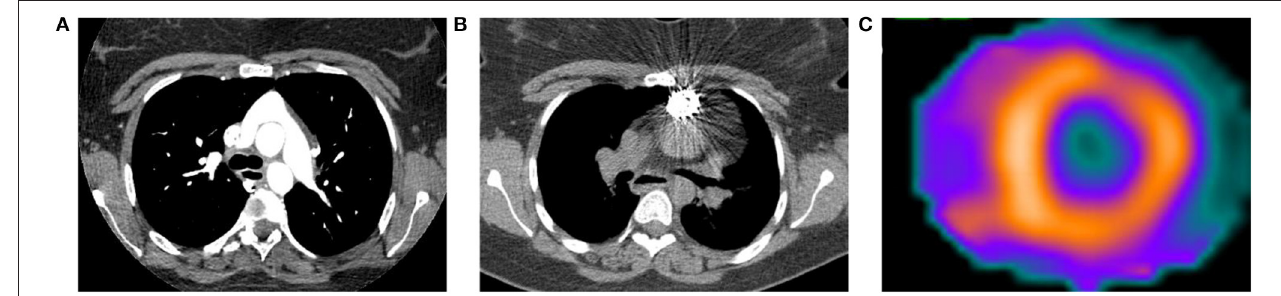
FIGURE 4 | Computed tomography (CT) and 99m Tc-sestamibi single-photon emission computed tomography (SPECT) images from a 23-year-old woman with history of D-transposition of the great arteries (D-TGA) status-post repair. (A) Transaxial CT angiogram image demonstrating the characteristic appearance of the pulmonary artery and aorta after repair of D-TGA. (B) Non-contrast CT acquired at time of SPECT shows a stent in the pulmonary artery that was placed after the patient developed severe pulmonary artery stenosis. (C) Short axis SPECT image shows normal radiotracer distribution in the left ventricle with extension of uptake into the visualized portion of the right ventricle, consistent with pulmonary hypertension.